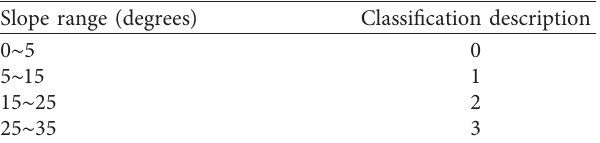
Table 1: Slope classification.